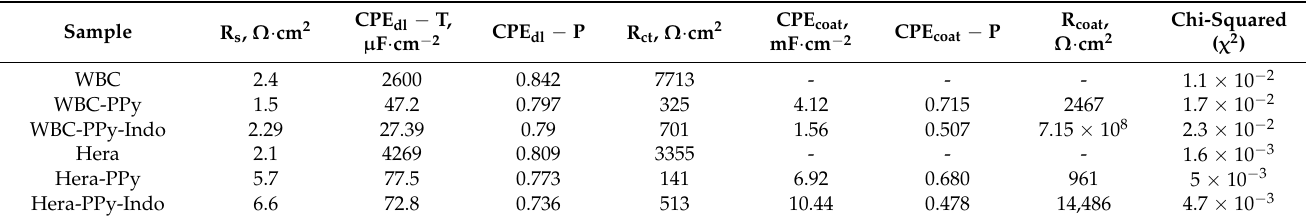
Figure 9. Models for the equivalent electrical circuit proposed for fitting the experimental impedance spectra, ( a ) for uncoated alloy and ( b ) PPy or PPY-Indo coated alloy. Table 3. The values of the equivalent electrical circuit elements for the uncoated and coated CoCr based alloys immersed in Tani-Zuchi artificial